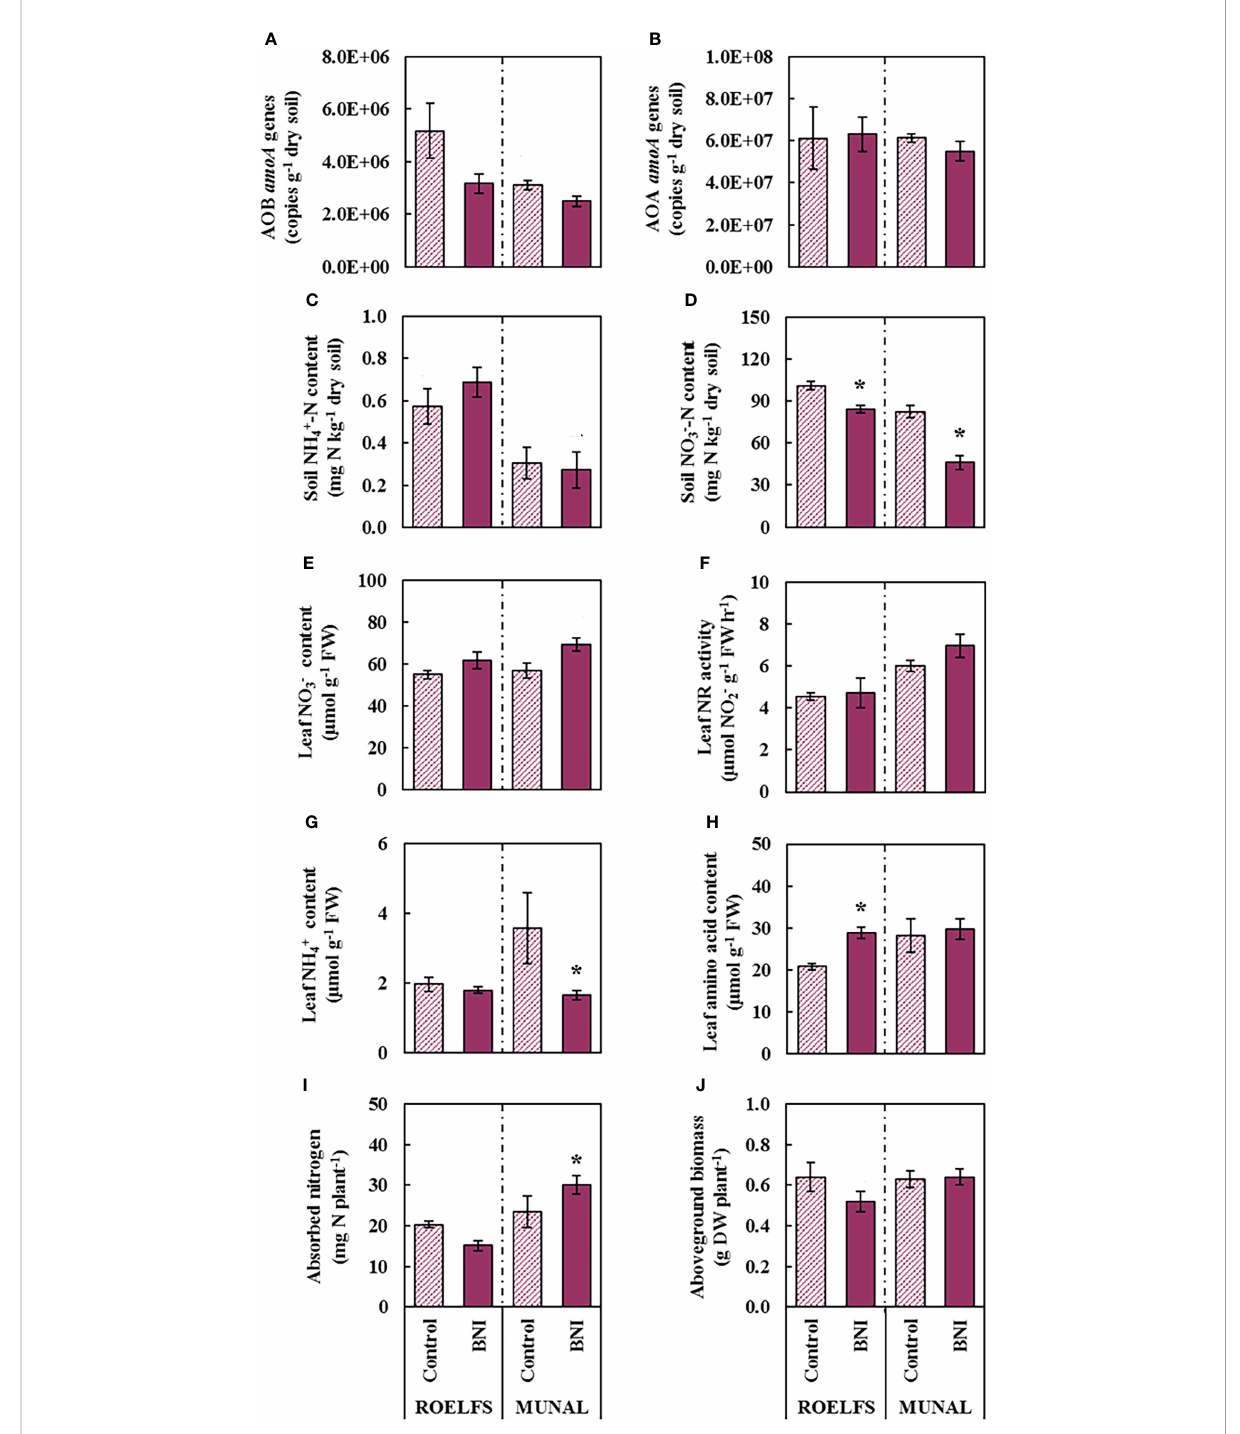
FIGURE 5 Performance of Control and BNI-isogenic-lines from ROELFS and MUNAL fertilized with potassium nitrate (KN) . Soil and plant parameters were measured 30 days post-fertilization (T30): Abundance of AOB (A) and AOA (B) , soil mineral nitrogen content such as ammonium (C) and nitrate (D) , and leaf determination of nitrate content (E) , nitrate reductase activity (F) , ammonium content (G) , amino acid content (H) , absorbed nitrogen (I) , and aboveground biomass (J) . The Mann-Whitney U test was used for the comparison between the absence or the presence of BNI-trait and the signi fi cant differences at p <0.05 are marked with an asterisk